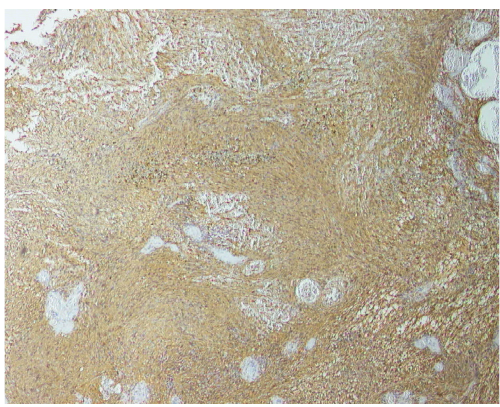
Figure 6: Immunohistochemistry showing tumor cells that are strongly positive for S-100. Table 1: Nasal septal schwannoma cases reported in the last 20